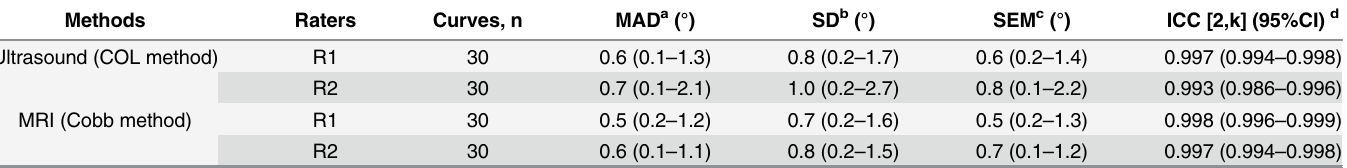
Table 1. Intra-rater variation and reliability of coronal curvature assessments using ultrasound compared with MRI.